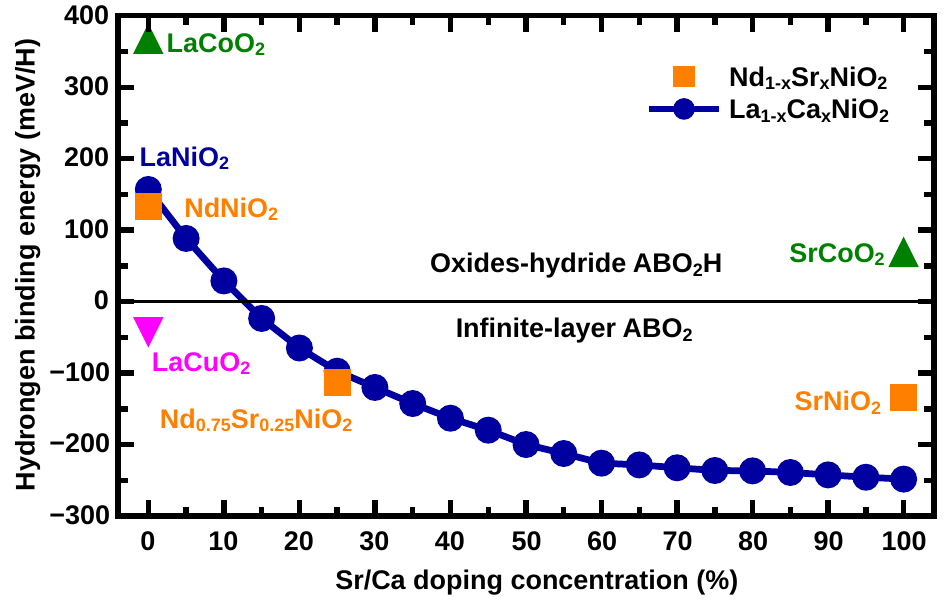
Figure 4. Hydrogen binding energy ( E b ) per hydrogen in two nickelate superconductors, La 1 − x Ca x NiO 2 and Nd 1 − x Sr x NiO 2 vs. Sr/Ca doping concentration x ; LaCuO 2 , LaCoO 2 , and SrCoO 2 are shown for comparison. Slightly above 10% (Sr,Ca)-doping infinite layer nickelates are ener- getically more stable. Note that the doping changes the filling of the B -3 d orbital. To study the relationship between E b and the types of B -site elements, E b of several other AB O 2 compounds is computed: LaCoO 2 , LaCuO 2 , SrCoO 2 and SrNiO 2 . Note that this changes the filling of B -3 d orbital within a large range: e.g., 3 d 8 for LaCoO 2 and 3 d 9 for LaNiO 2